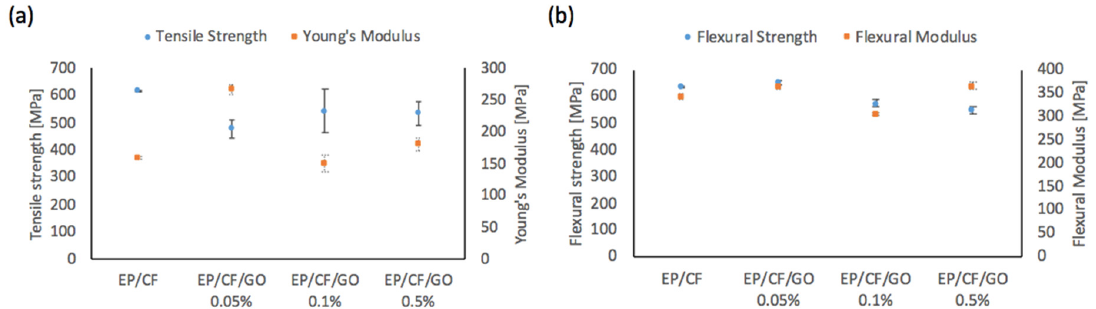
Figure 2. Comparison of mean values of epoxy-reinforced carbon fiber (EP/CF)-based samples reinforced with graphene oxide (GO) of ( a ) tensile properties and ( b ) flexural properties.